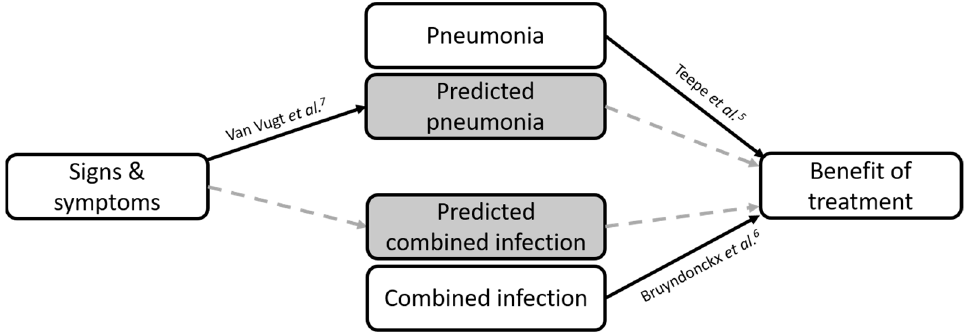
Figure 1. Schematic overview of the objective of this manuscript: full lines are covered in referred manuscripts; dashed lines are covered in this manuscript (5,6,7 in the figure refer to reference